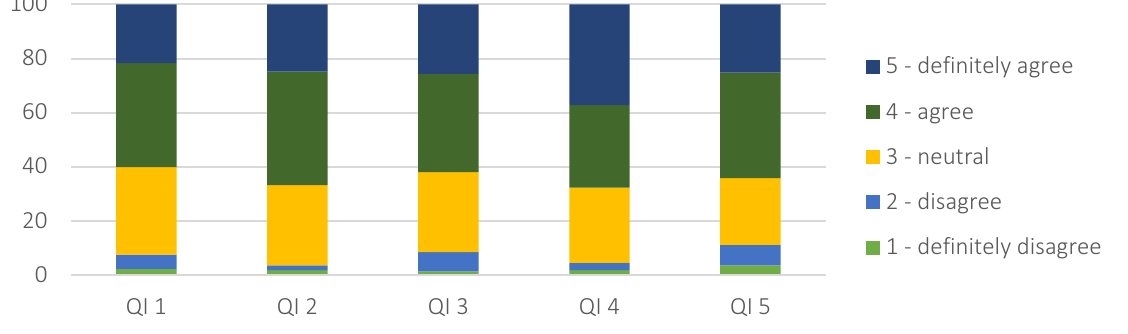
Figure 2. Information quality